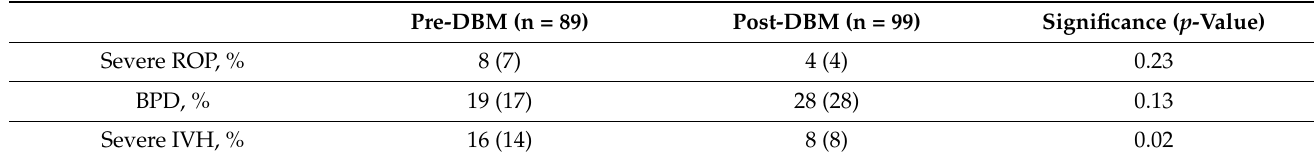
Table 2. Summarizes the differences in tertiary endpoints between the two infant